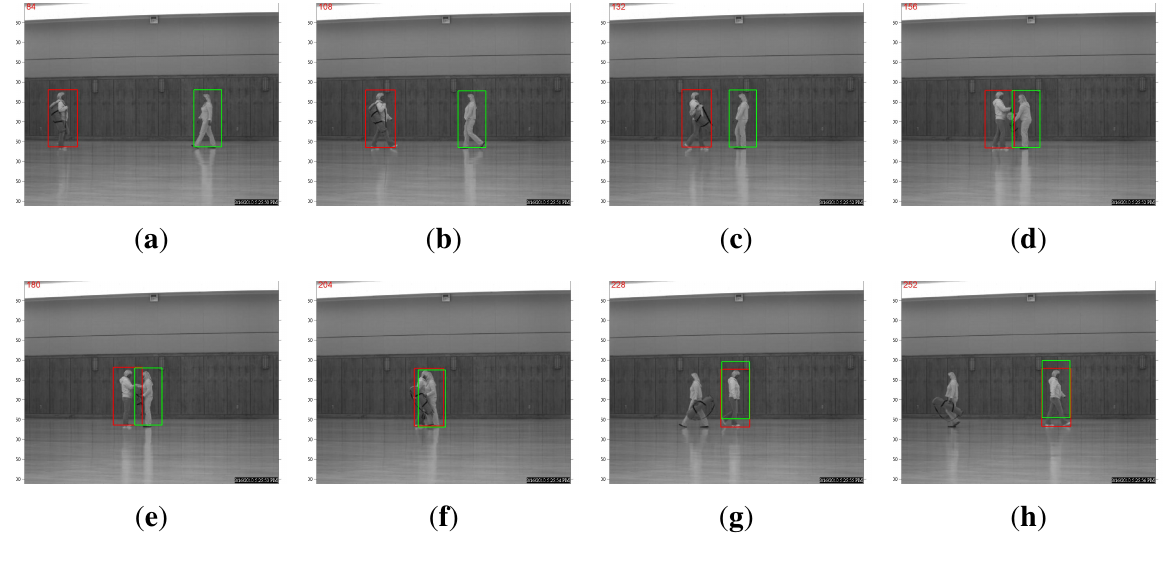
Figure 3. Tracking failure result obtained by [11] due to occlusion (after the two persons pass by each other, the tracking algorithm got confused; both red and green boxes get attached to the pedestrian walking to the right).